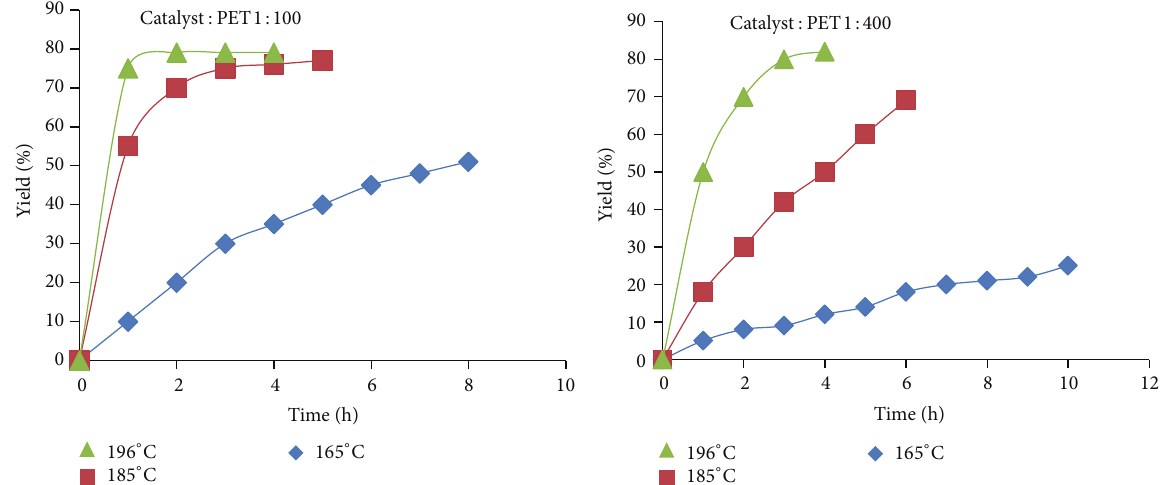
Figure 14: The effect of temperature, time, and concentration of catalyst on the yield reaction in the presence of sodium carbonate